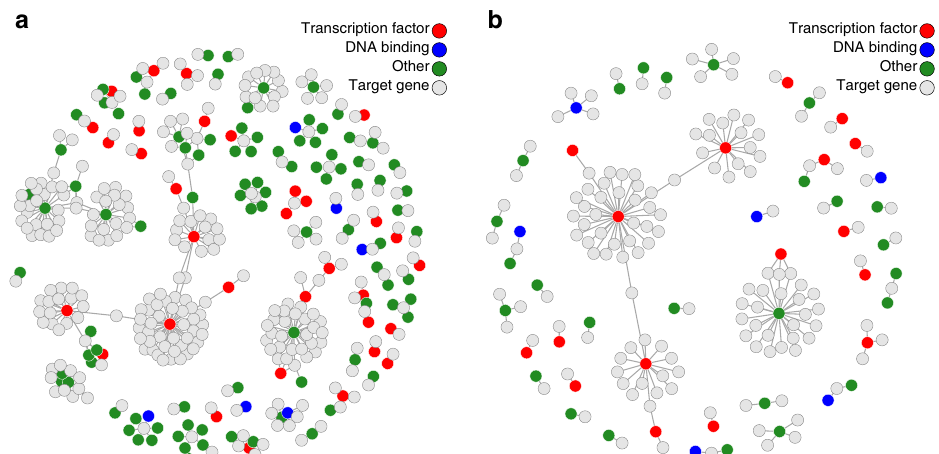
Fig. 2 Gene networks showing the directed gene – gene association between genes. Panels show the associations when not taking LD and local pleiotropy into account ( a ) and when these are corrected for ( b ). Index genes identi fi ed as a transcription factor are indicated by red circles. Blue circles indicate index genes with DNA binding properties, but are not a known transcription factor 22 . Green circles indicate other index genes. Light grey circles indicate target genes. The uncorrected analysis shows 134 index genes (coloured circles) in fl uencing 276 target genes, where several neighbouring index genes seemingly in fl uencing the same target gene, which is re fl ective of a shared genetic component of those index genes. Speci fi cally, 65 target genes are associated with multiple index genes which lie in close proximity to one another. The number of index genes drop sharply from 134 to 49 (2.7-fold decrease) when do taking LD and local pleiotropy into account. The number of target genes also drops, from 276 to 144 (1.9-fold